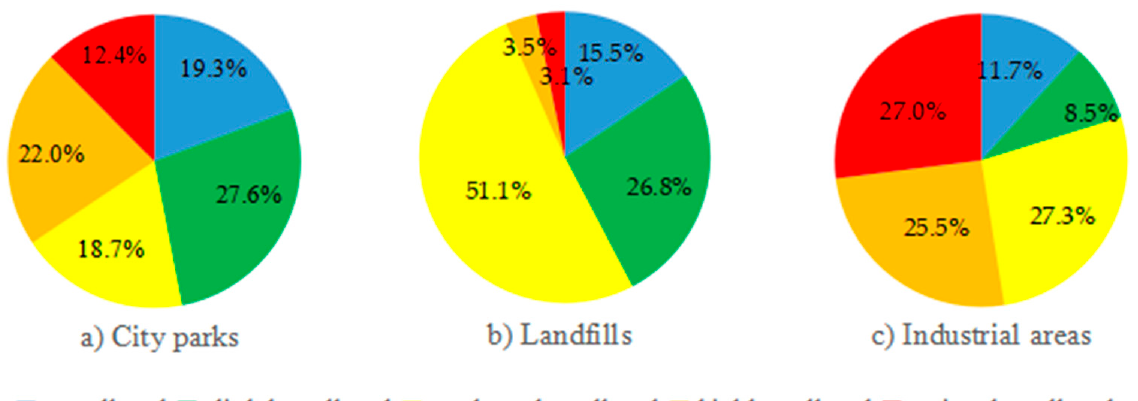
Figure 3. Soil heavy metal pollution assessment results by previous studies for the city of Guang- zhou. ( a ) City parks (revised from [13,51,56,67,72]), ( b ) Landfills (revised from [14,55,59,73]), and ( c ) Industrial areas (revised from [13,14,47,49,53,57,60,61]).